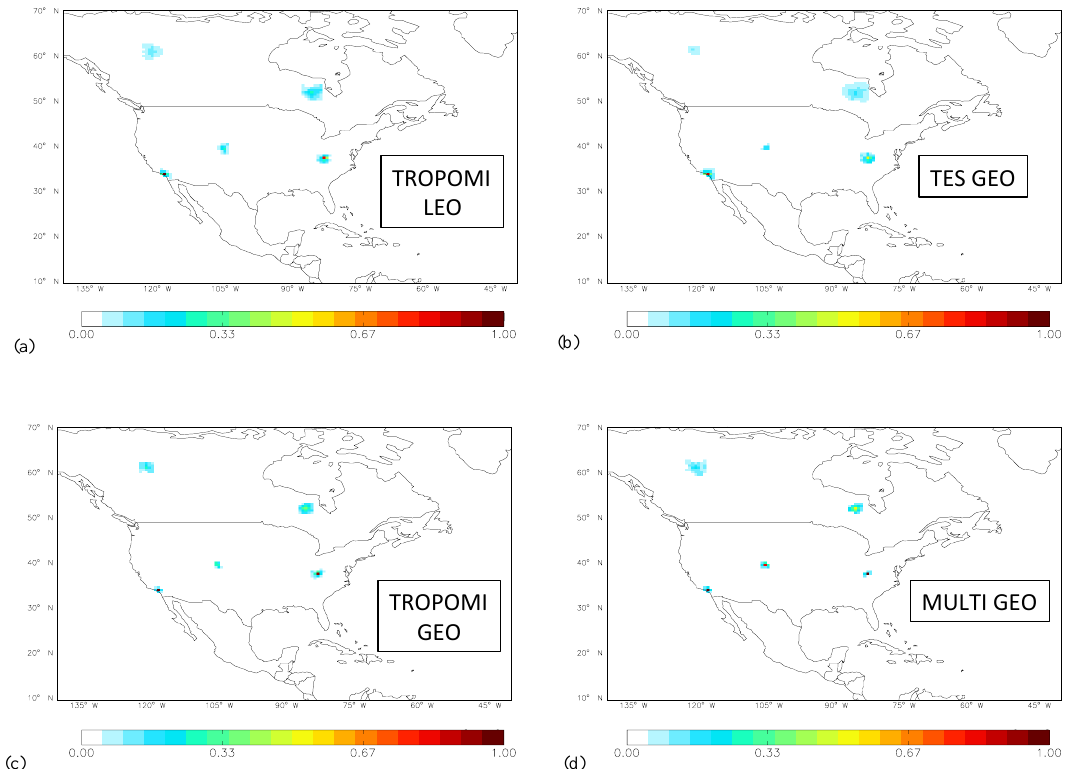
Figure 8. Rows of the model resolution matrix (unitless) for five locations for a 7-day inversion (1–8 July 2008), using (a) TROPOMI low-Earth orbit observations (TROPOMI_LEO); (b) GEO-CAPE observations with a TES-like instrument (TES_GEO); (c) GEO-CAPE observations with a TROPOMI-like instrument (TROPOMI_GEO); and (d) GEO-CAPE observations with a multi-spectral instrument (MULTI_GEO). Coordinates of the five locations considered are reported in Table 1 and approximately correspond to the peak value of each structure on the